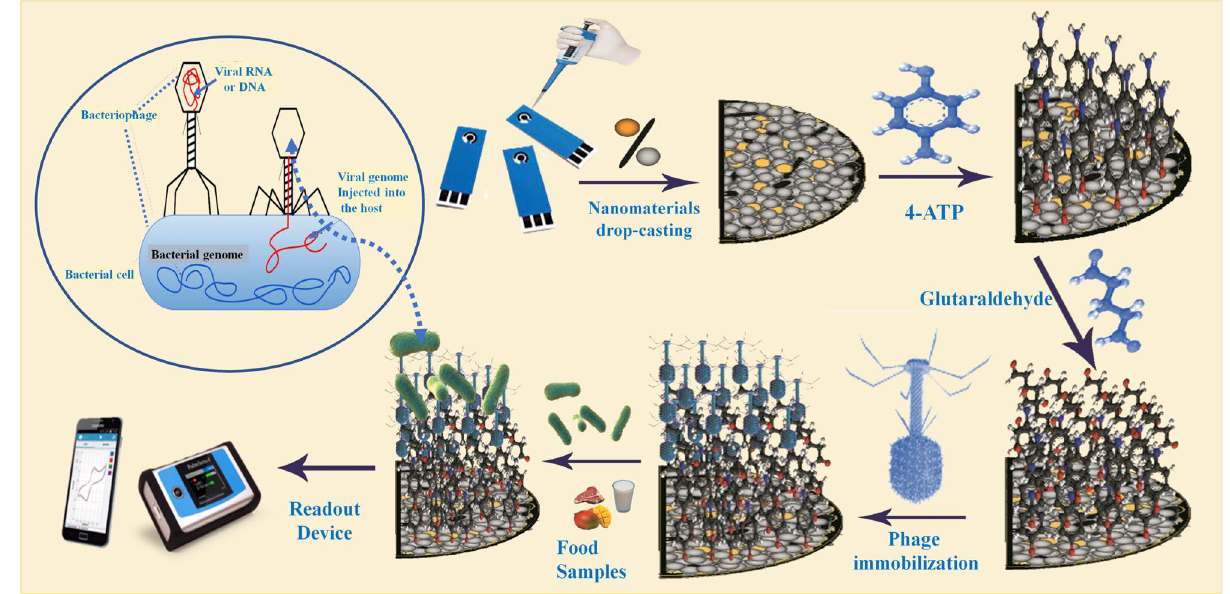
Figure 1. Subsequent process of the fabrication of the phage-based biosensing approach for the rapid impedimetric detection of E. coli . Firstly, the electrode surface modification with nanomaterials was carried out before forming a self-assembled monolayer of 4-ATP as the main cross-linker. Then, surface activation by glutaraldehyde solution (2%) was conducted before the immobilization of the targeting bacteriophage. Eventually, applications on food sample analysis were performed using the PalmSens-4 portable